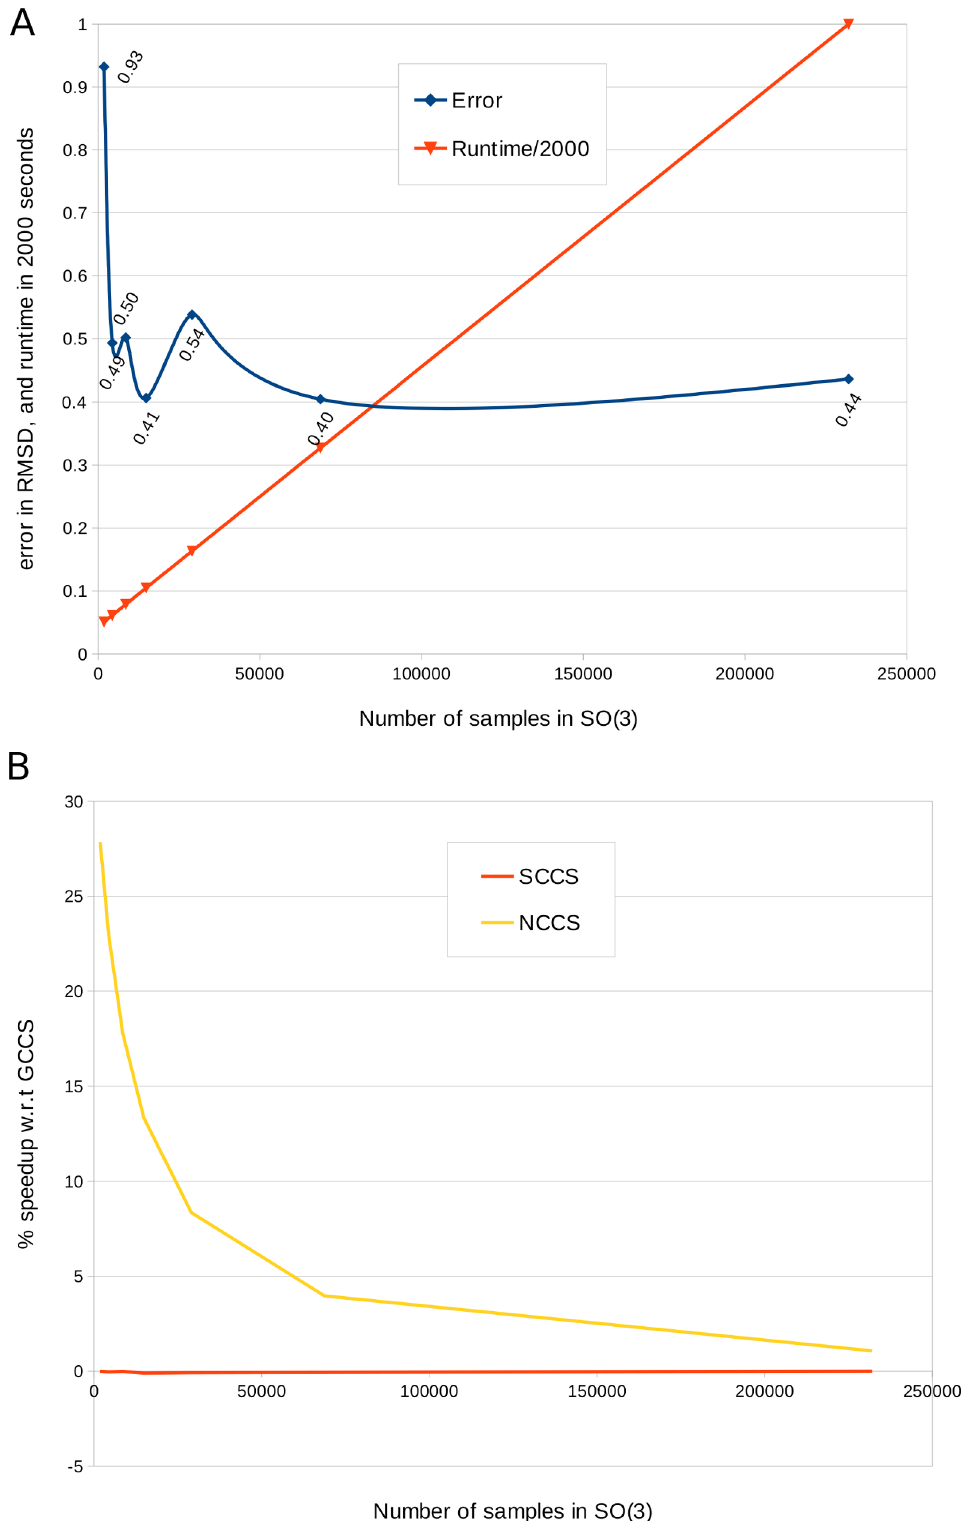
Fig 7. Speed-accuracy trade-offs in PF 2 fit . (A) The plot displays the average runtime (divided by 2000) using the GCCS scoring term, and the corresponding error (in RMSD) when PF 2 fit is applied on the synthesized EM dataset. Notice that the runtime increases linearly with the number of